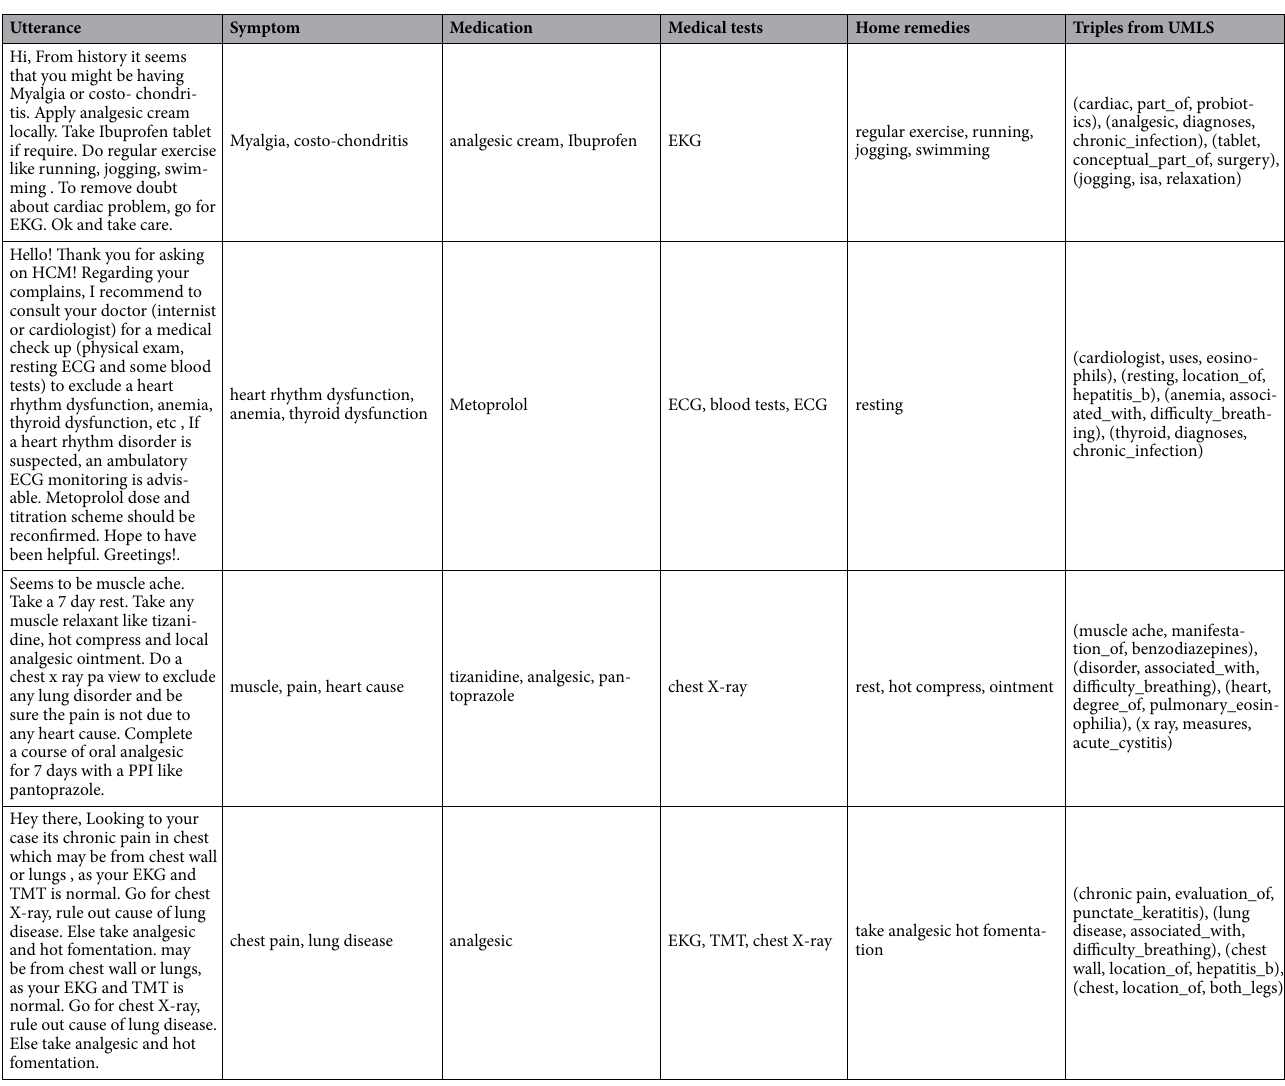
Table 3. Predicted entities using MEP